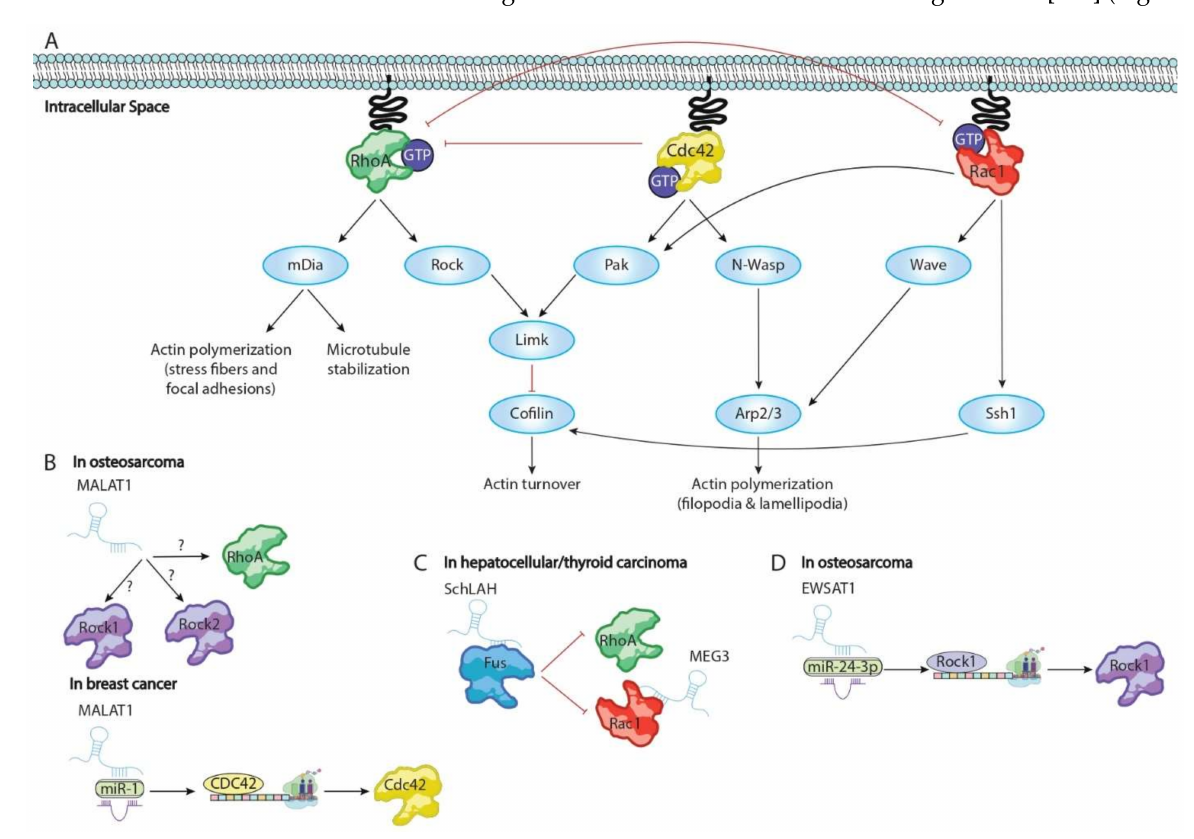
Figure 4. Schematic representation of lncRNAs involved in Rho/ROCK signaling: ( A ) pathways mediated by Rho/ROCK signaling; ( B ) Malat1 increases RhoA, ROCK1, and ROCK2 expression in osteosarcoma progression while acting as sponge by binding to miR-1, leading to Cdc42 translation in breast cancer; ( C ) SchLAH represses RhoA and Rac1 interacting with Fus; ( D ) EWSAT1 enhances ROCK1 translation by avoiding that miR-23-3p recognizes ROCK1 3 (cid:48)